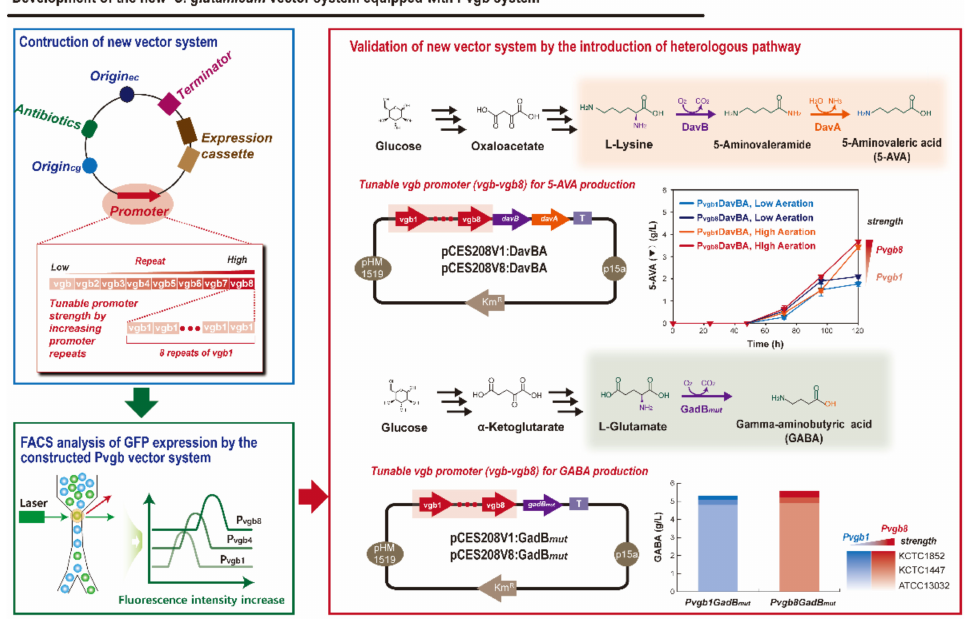
Figure 1. Schematic representation of the development of the C. glutamicum P vgb promoter-based vector system equipped with P vgb promoter.